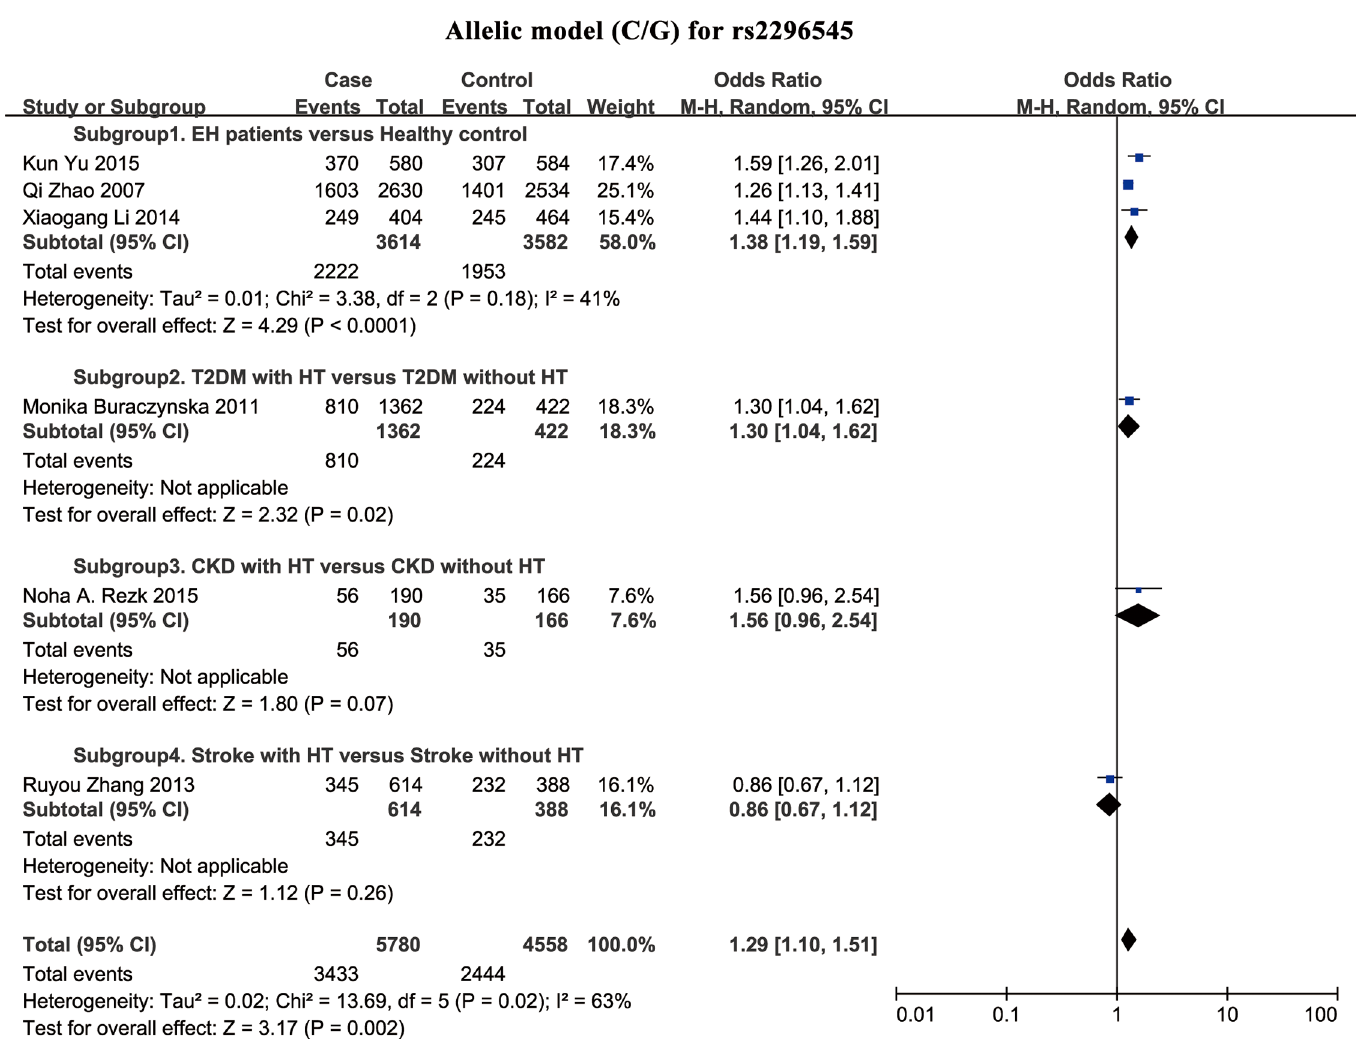
Fig 2. Forest plot of the association between rs2296545 and risk of HT in the allelic model (C/G). Case events indicate hypertensive subjects; Control events indicate normotensive subjects. Note: In Table 2, summary OR for subgroup 1 analysis (allelic model for rs2296545) was been calculated by fixed- effects model (I 2 = 41%); while, Fig 2 showed this association for combined analysis, other than subgroup 1 analysis, by using random-effects model (I 2 = 63%). This is the reason for different OR values showed in Table 2 (OR = 1.33) and Fig 2 (OR = 1.38) under subgroup 1